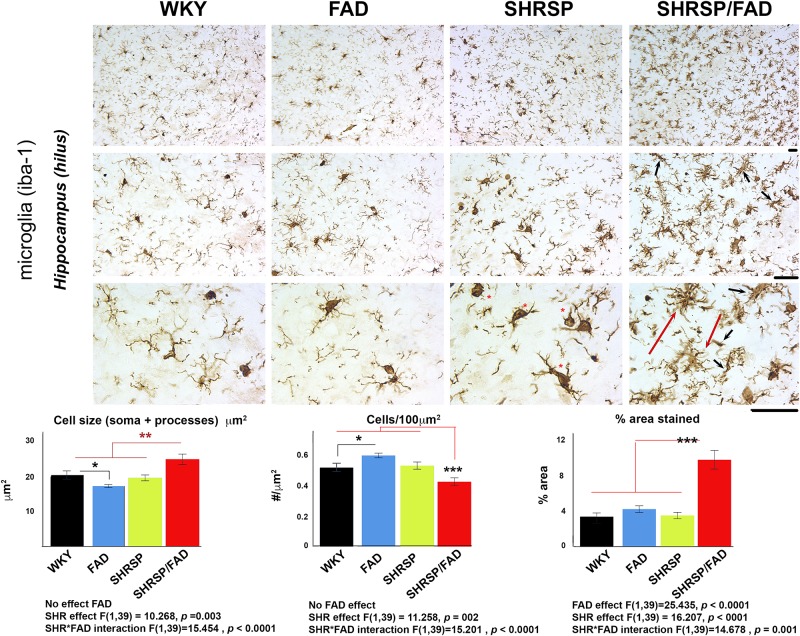
Microglial staining and cell size are increased in SHRSP/FAD rats. Micrographs show Iba1-positive microglia in the hippocampus of the four strains. Microglia in SHRSP, FAD and WKY rats all showed normal ramified morphology with well-defined soma, which was more pronounced in the SHRSP rats (red asterisks). In contrast, microglia in the SHRSP/FAD rat showed hyper-ramified, thickened bushy processes (red arrows) and narrowed soma, some with rod morphology (black arrows). Two-way ANOVA (FAD × SHRSP) and showed a main FAD effect in percent area (p < 0.0001) and a significant SHRSP × FAD interaction (p = 0.001). Post hoc analysis showed that percent area stained for Iba1 was elevated in the hippocampus of SHRSP/FAD rats, compared to all other groups (p < 0.001). In fact this interaction was also seen with cell number and cell size, which post hoc analysis revealed was similarly due to significantly increased Iba1-positive cell number in SHRSP/FAD rats, compared to all other groups combined (p = 0.005). Number of microglia was significantly increased in FAD rats, compared to WKY, whereas cell count was significantly reduced in SHRSP/FAD rats, compared to SHRSP, despite increased area, associated with processes in SHRSP/FAD animals. Data represent means ± SEM. ∗p < 0.05, ∗∗p < 0.01, and ∗∗∗p < 0.001; two-way ANOVA with LSD Fisher’s post hoc test.